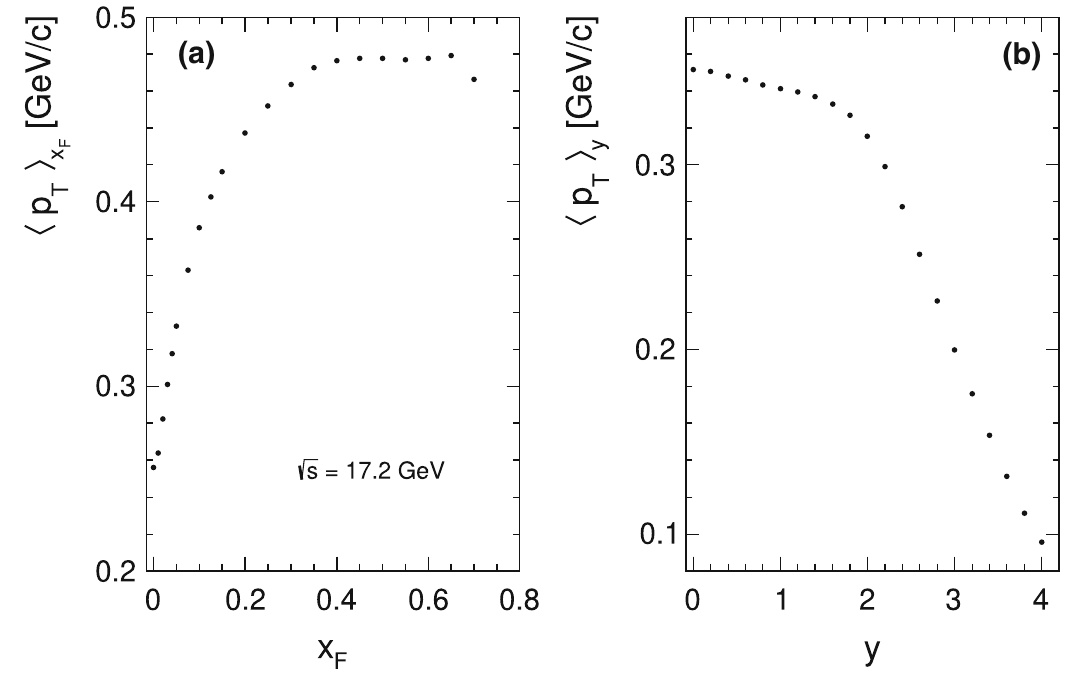
Fig. 136 Mean transverse momentum (cid:4) p T (cid:5) as a function of (a) x F and (b) rapidity integrated in the limit 0 < p T < 1.3 GeV/c